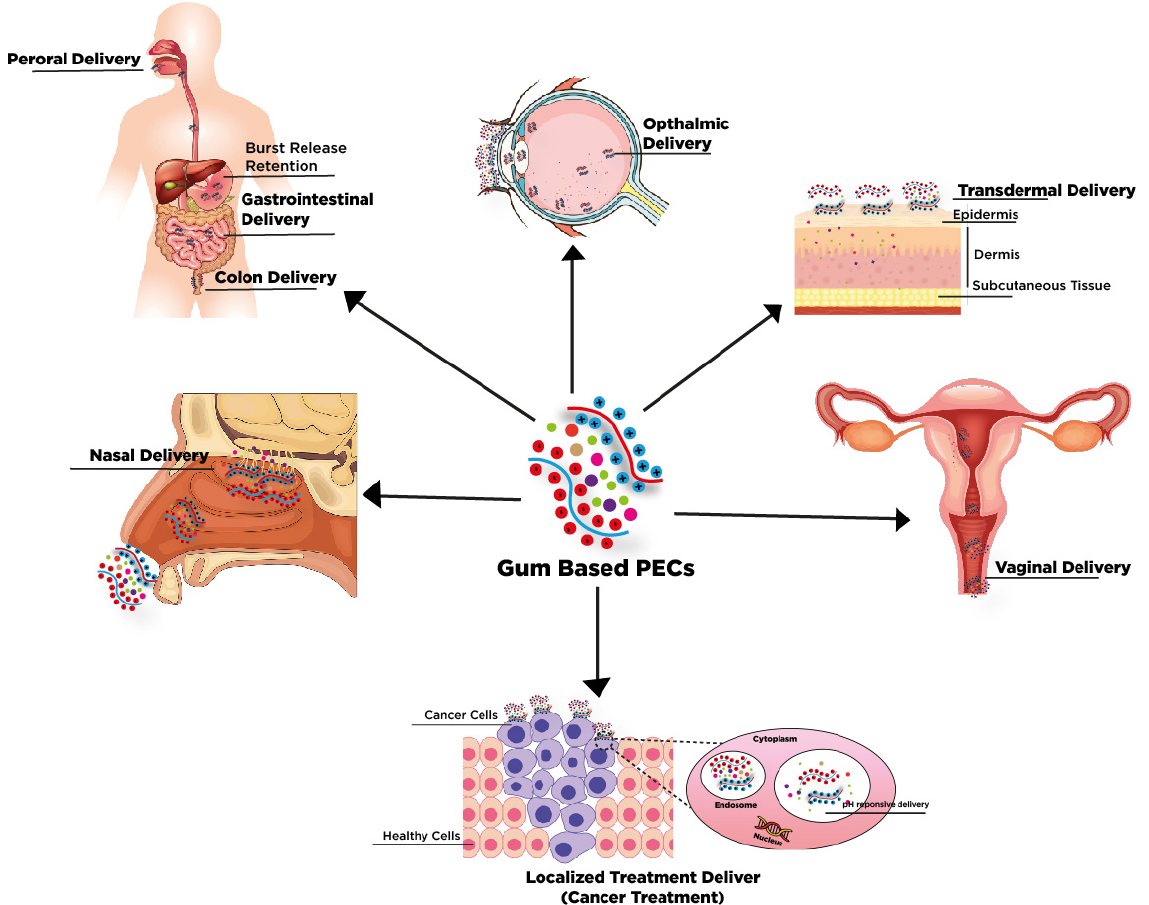
Figure 2. Drug administration route.